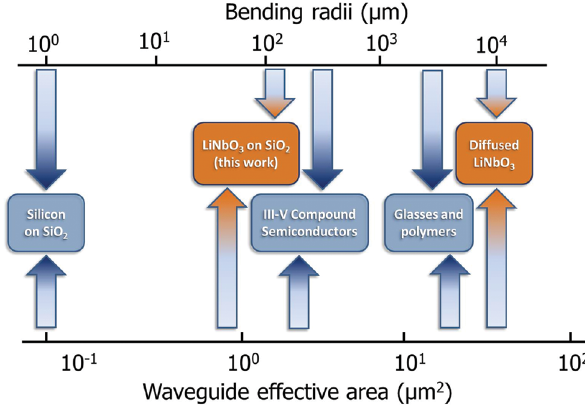
waveguide platform in Figure 9 Improvements attained in LiNbO 3 terms of waveguide effective areas and minimum radii for negli- gible ( < ∼ 0.1 dB) bending loss at 90 ° turns based on the approach presented in the text and its comparison with other platforms. Δ n denotes the approximate core-cladding index contrasts of the wave- guide platforms